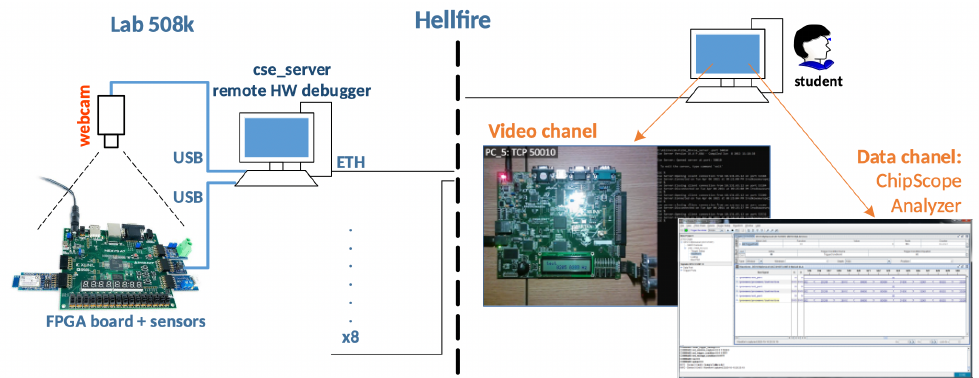
Figure 1. System architecture for designing FPGAs operating under the IoT concept. The right side of the firewall shows the camera view that a student sees and a screen of the software used for remote programming. The left side of the firewall shows the conceptual connection between the PC and a prototype board with an FPGA chip and the connection of the webcam transmitting the image from the preview in the